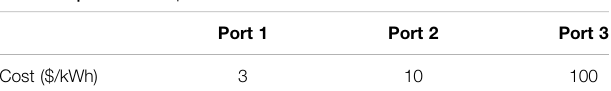
TABLE 1 | Load interruption